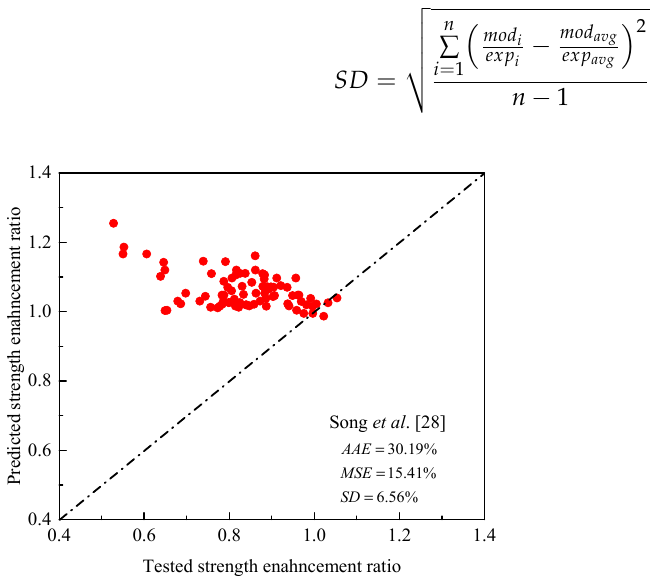
Figure 1. Comparison between tested and maximum load ratios by the model of Song et al. [28] for FRP-confined RC columns.